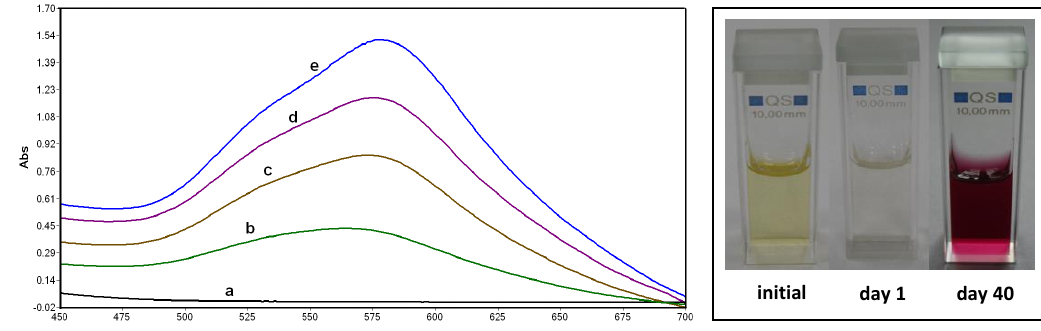
Figure 2. Evolution of the UV-Vis absorption spectrum of the bovine serum albumin (BSA) / HAuCl 4 system at different stages of incubation: (a) initial, (b) 3 days, (c) 1 week, (d) 2 weeks and (e) 3 weeks. Inset: Color change accompanying the formation of gold nanoparticles.